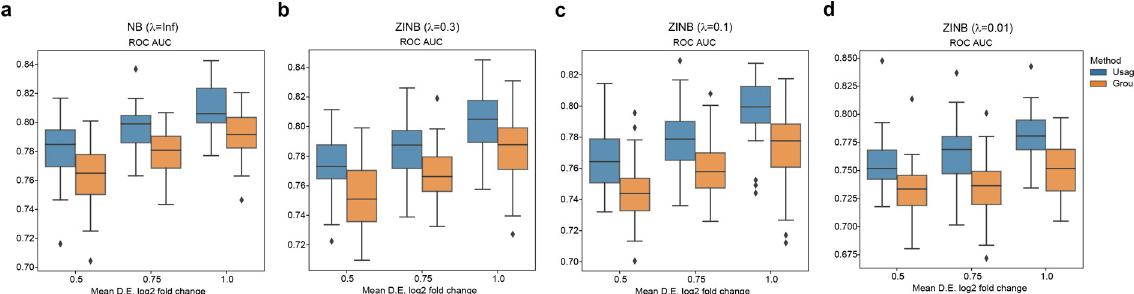
Fig 4. Comparisons of DEG identifications between using continuous usages and discrete group assignment. (a) ROC AUC results for datasets simulated under NB distributions. (b) Results for datasets simulated under ZINB distributions with λ = 0.3. (c) Results for datasets simulated under ZINB distributions with λ = 0.1. (d) Results for datasets simulated under ZINB distributions with λ = 0.0. The values of ROC AUC were calculated across different signal-to-noise ratio levels. Each box and whisker plot was plotted based on ten simulated datasets. Central lines represent medians, boxes represent the interquartile range (IQR), and the upper/lower whisker represents the largest/smallest value no further than 1.5 × IQR. ROC: receiver operating characteristic; AUC: area under curve.